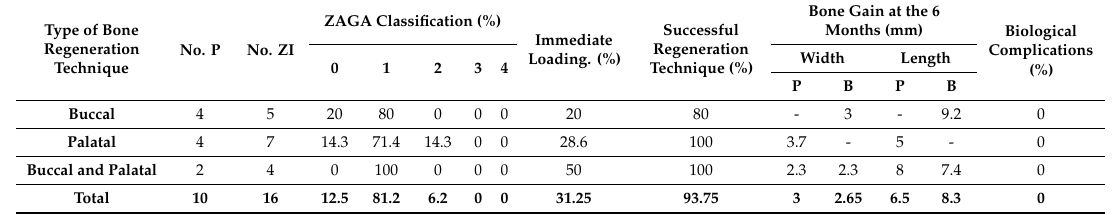
Table 3. Data referred to number of patients, number of zygomatic implants, ZAGA classification, immediate loading, successful regeneration technique, bone gain at the 6 months and biological complication at the implant level according to the type of bone regeneration technique.